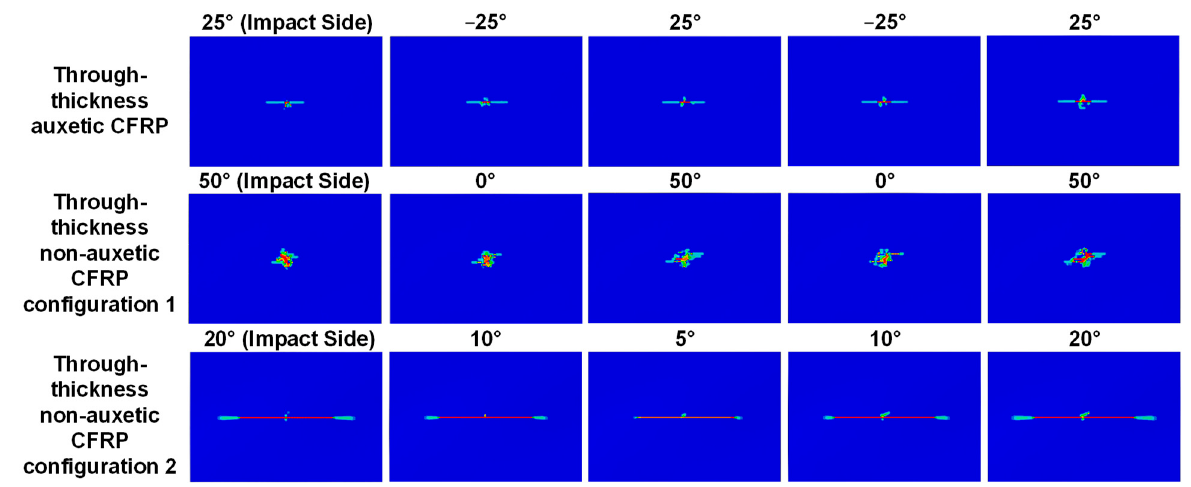
Figure 11. Effect of the through-thickness negative Poisson’s ratio on the fiber tensile damage: comparison of the predicted fiber tensile damage pattern in each ply of the auxetic CFRP composite laminate (layup: [25 2 / − 25 2 /25 2 / − 25 2 /25 2 ], results shown in the first row) and the corresponding non-auxetic CFRP composite laminates (layups: [50 2 /0 2 /50 2 /0 2 /50 2 ] and [20 2 /10 2 /5 2 /10 2 /20 2 ], results shown in the second and third rows), at an 8 J impact. The red color indicates complete damage while the blue color indicates no damage.